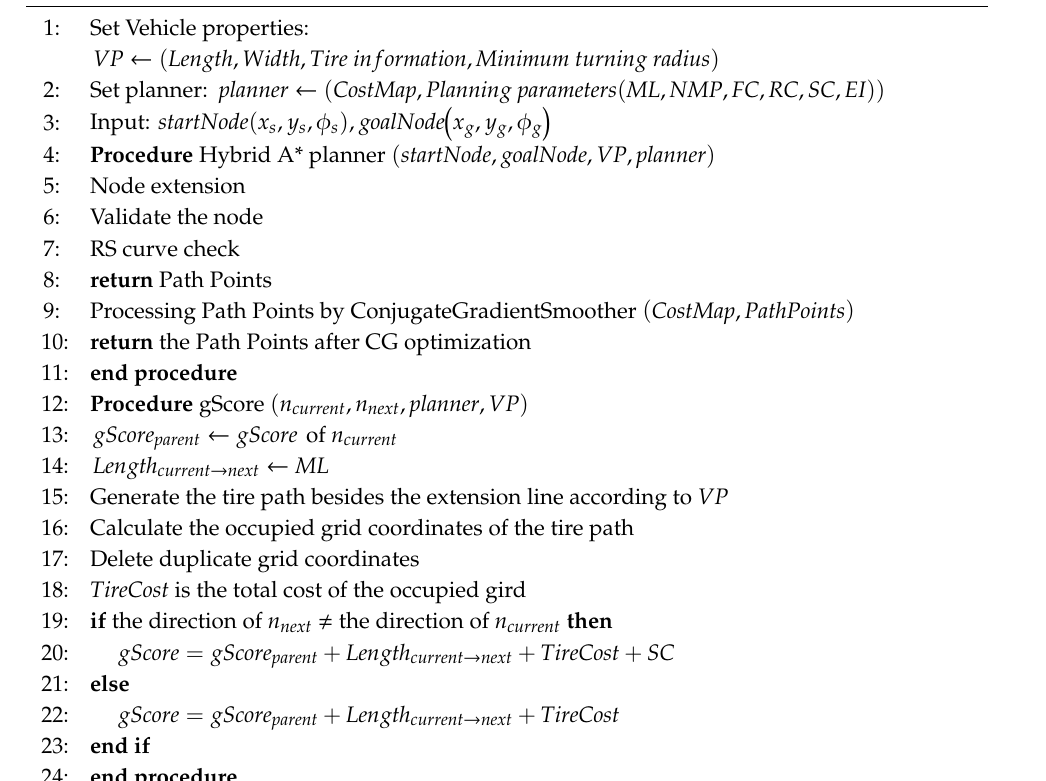
Algorithm 1 Modified Hybrid